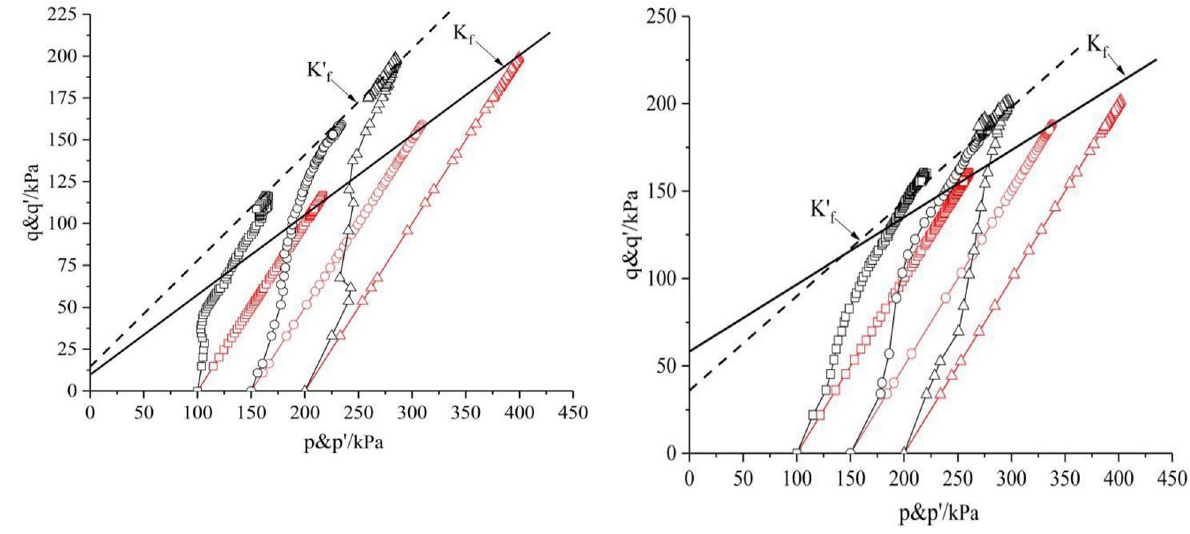
Fig 9. p~q curve with ρ d = 1.7 g/cm 3 . (a) Shear rate v = 0.16 mm/min . (b) Shear rate v = 0.4 mm/min .